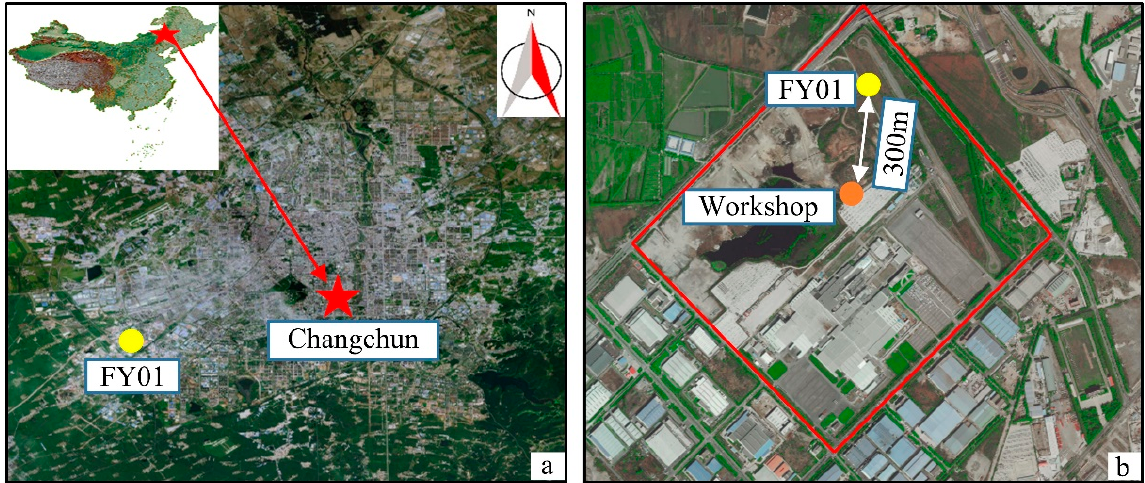
Figure 1. ( a ) Study region location. ( b ) Well position and heating goal on a satellite